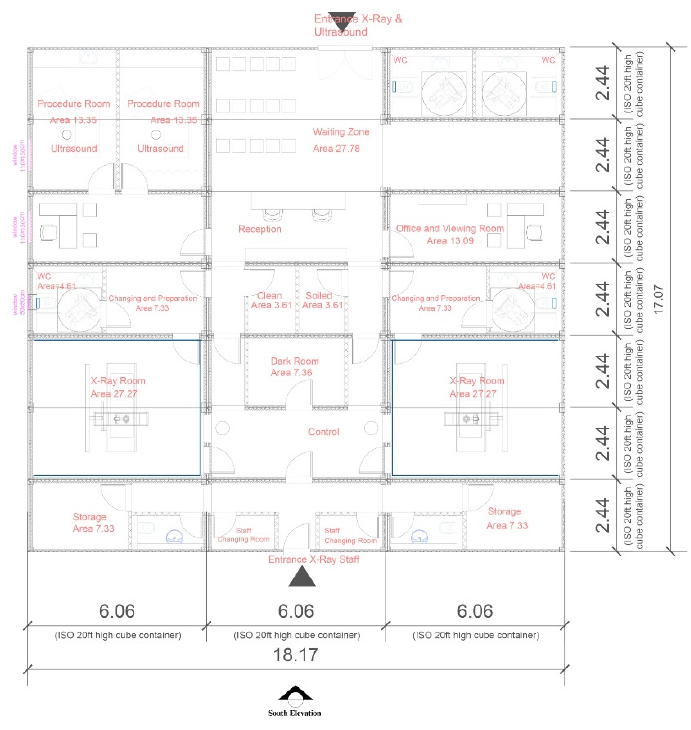
Figure A6. Radiology department plan of the relocatable hospital in Mosul.